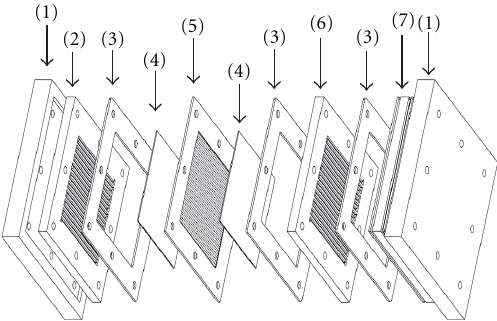
Figure 1: An exploded view of a PEM fuel cell stack. (1) clamping plate; (2) End plate; (3) gasket; (4) gas di ff usion layer; (5) SPE/catalyst layer; (6) bipolar plate; (7) additional stacked